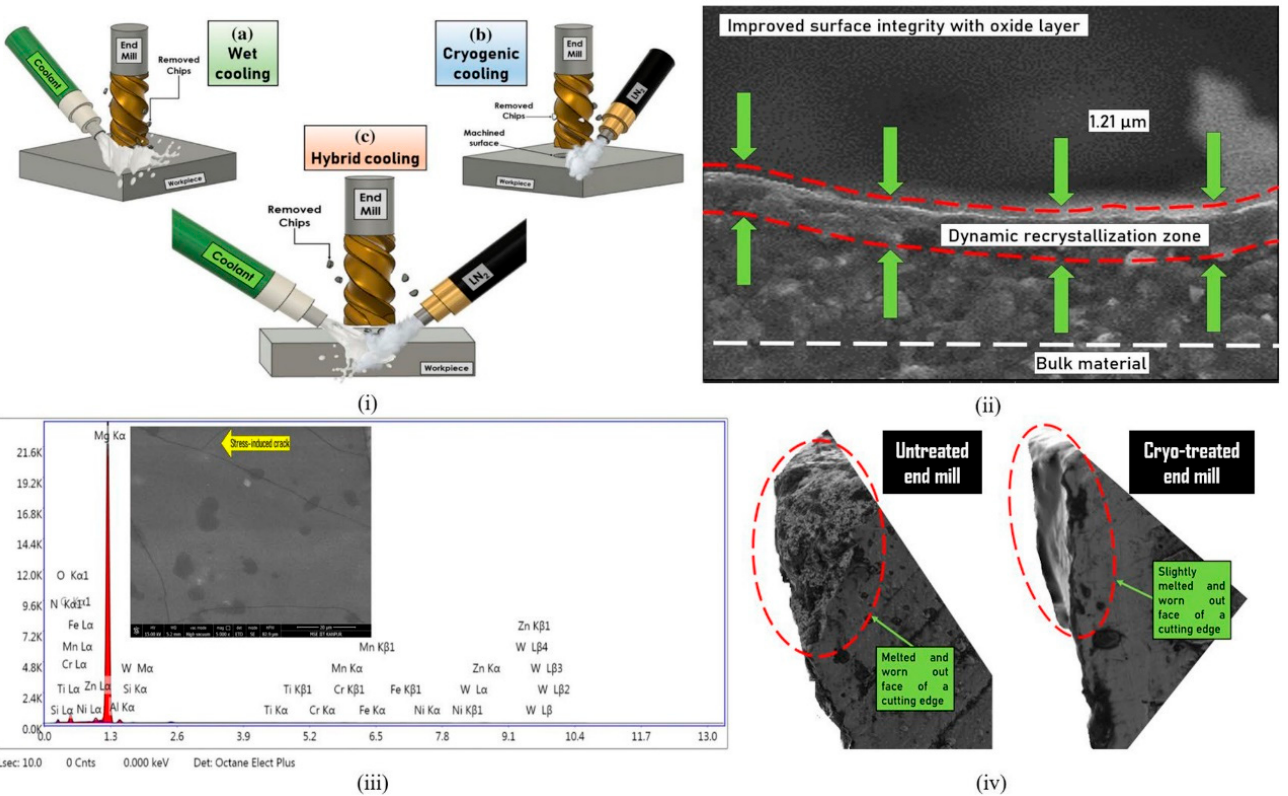
Figure 5. ( i ) Schematic diagram of three different milling environments of machining Mg alloy AZ31B; ( ii ) SEM demonstration of the featureless oxide layer on the surface hybrid-milled (wet + cryo) by cryo-treated end mill; ( iii ) EDS and SEM image of the surface hybrid-milled by cryo-treated end mill; ( iv ) SEM images displaying tool wear in both the end mills [74]. Reprinted from J. Mater. Eng. Perform., 29, Davis, R.; Singh, A., Tailoring Surface Integrity of Biomedical Mg Alloy AZ31B Using Distinct End Mill Treatment Conditions and Machining Environments, 7617–7635, 2020, with permission from Elsevier.